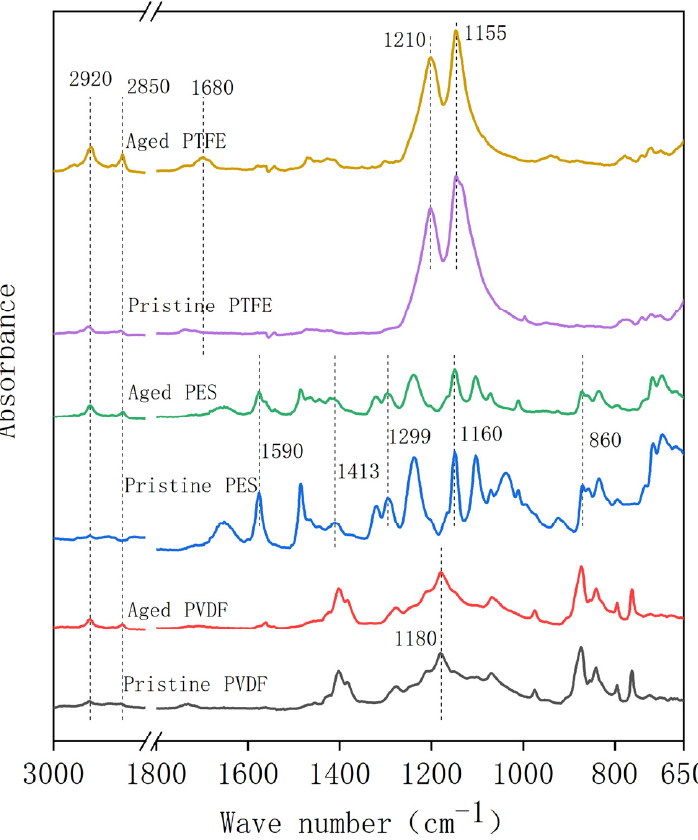
Figure 4. The FTIR of pristine and aged (five-years equivalent) membranes in the acid aging test.